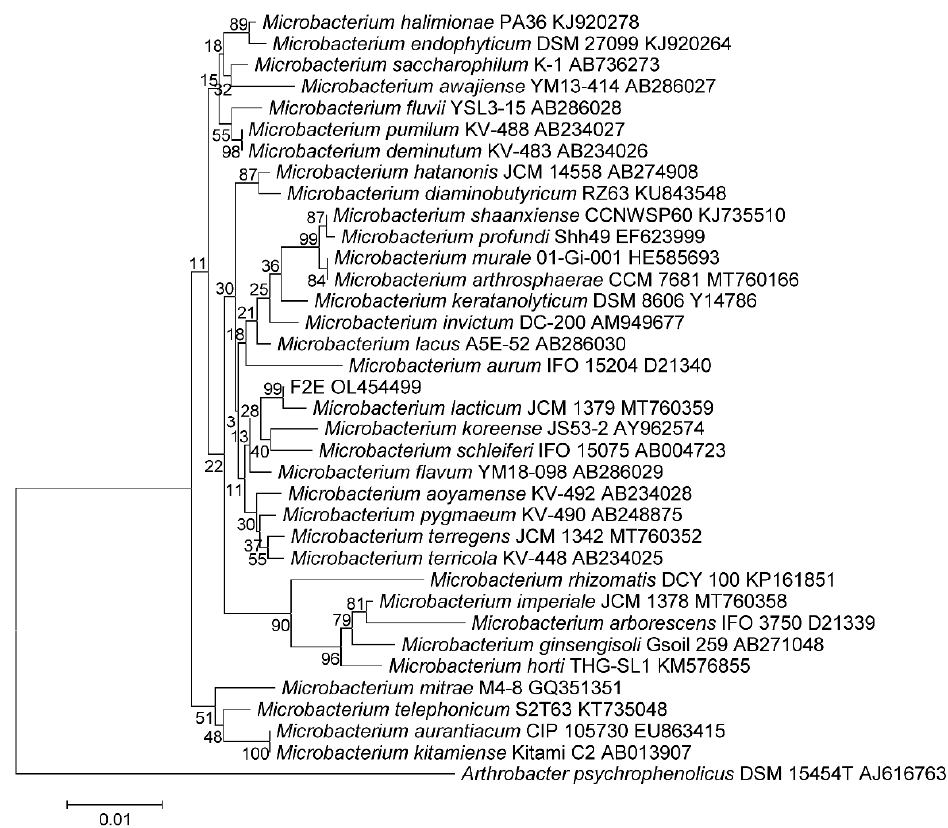
Figure 2. Neighbor-joining phylogenetic tree based on the 16S rRNA gene sequences showing the relationships of the strain F2E among members of the genus Microbacterium . Bar, 0.01 substitutions per nucleotide position.